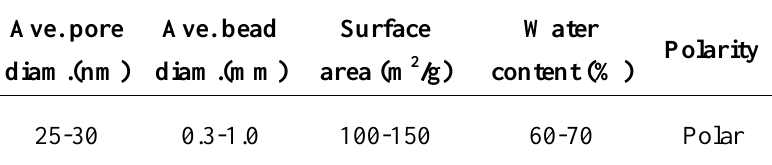
Table 2. Physical characteristics of macroporous ADS-7 resin *